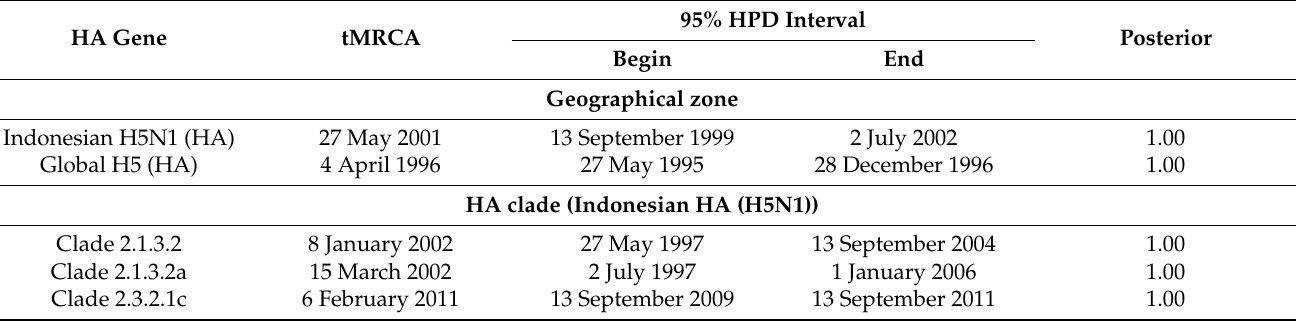
Table 2. tMRCA of HA of HPAIv (H5N1) Indonesian poultry and worldwide H5, determined by using a relaxed clock, with 95% HPD and posterior